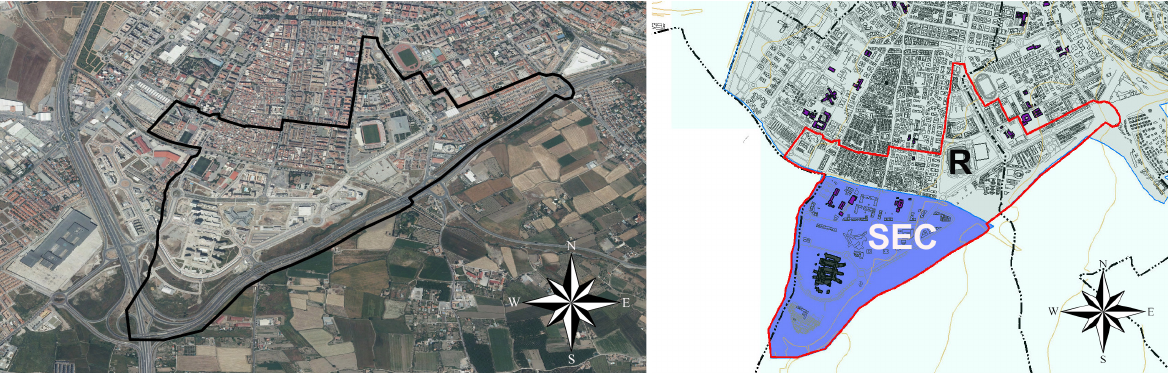
Figure 2: Study area contour (left) and situation within acoustic areas context